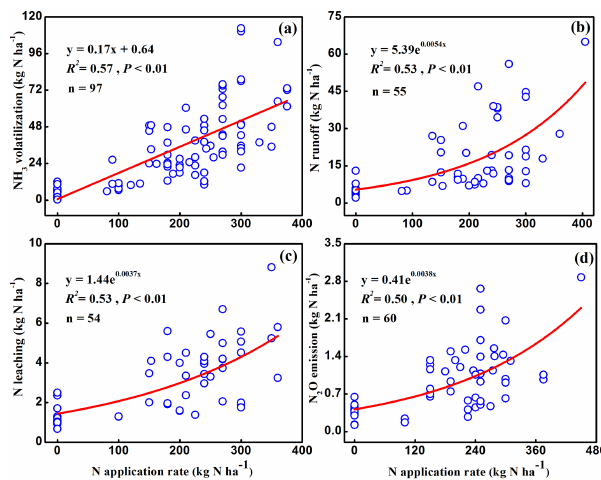
Figure 4. Relationship between N fertilizer application rate and (a) NH 3 volatilization, (b) N runoff, (c) N leaching, and (d) N 2 O emissions for rice production in the Taihu Lake region. These rela- tionships were obtained through a meta-analysis.